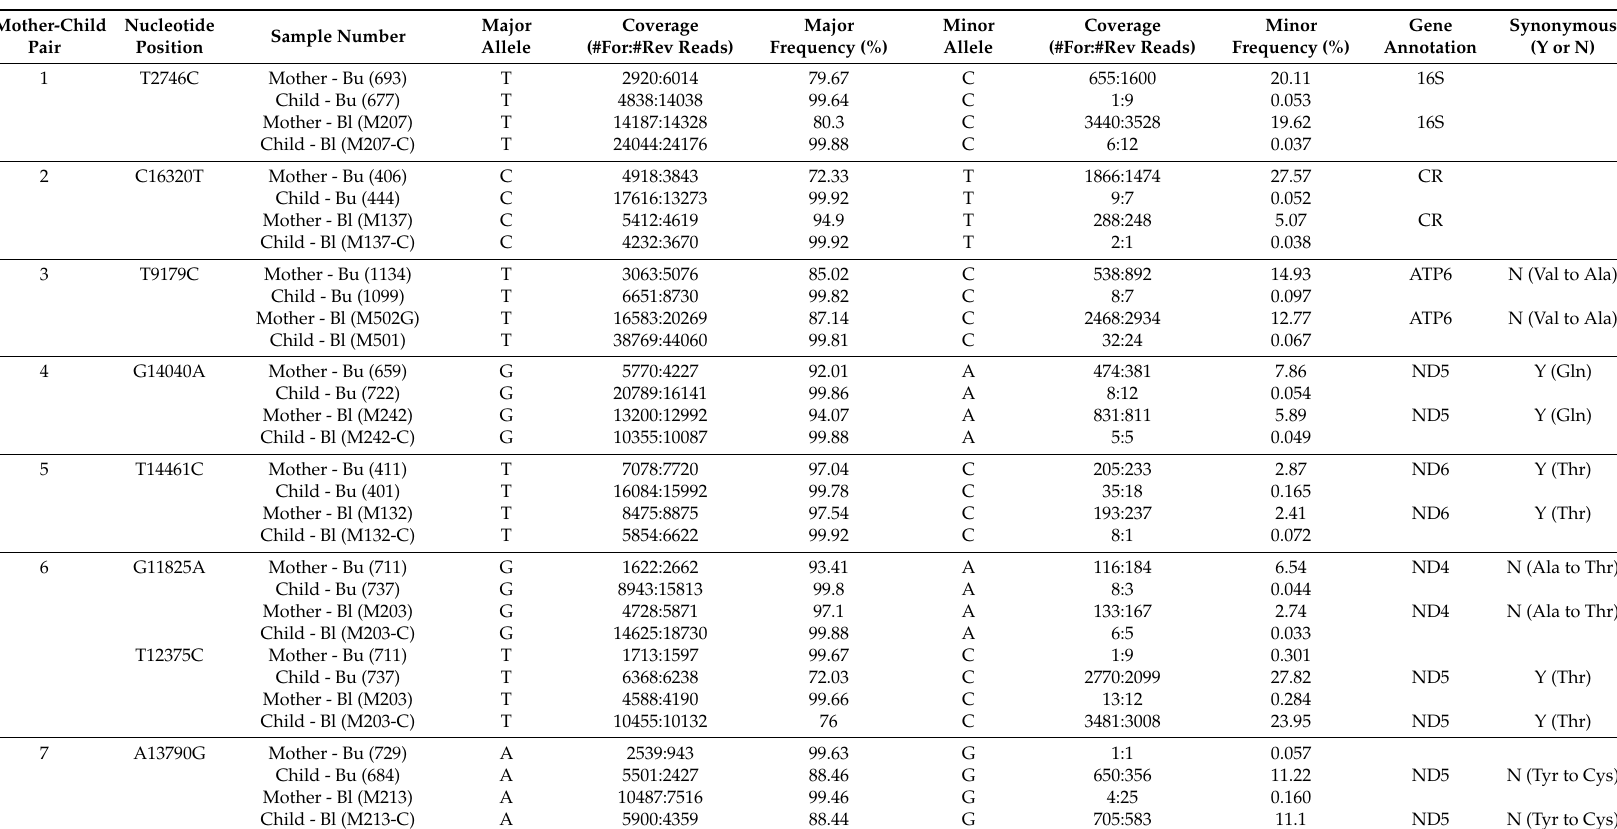
Table 2. Differentiating heteroplasmy for 17 of the 39 mother-child pairs; buccal cell (Bu) and blood (Bl) samples. Frequency of heteroplasmy at each np in percentage (%), with the minor variant annotated as the letter after the np; i.e., T2746C is heteroplasmy at np 2746, with 20.11% of the C variant. Coverage and read distribution (forward reads, #For, compared to reverse reads, #Rev) are provided for each np of differentiating heteroplasmy, along with the gene annotation and whether sites in protein coding genes result in a synonymous change (Y) or not (N). The gene annotations include: CR = control region, 12S & 16S = 12S & 16S rRNAs, ATP6 = ATP synthase 6, ND = NADH dehydrogenase, tRNA thr = tRNA for threonine, and CO = cytochrome oxidase. Metadata for samples without the heteroplasmy are provided to illustrate that read percentages are clearly below reporting threshold and that coverage was adequate for this